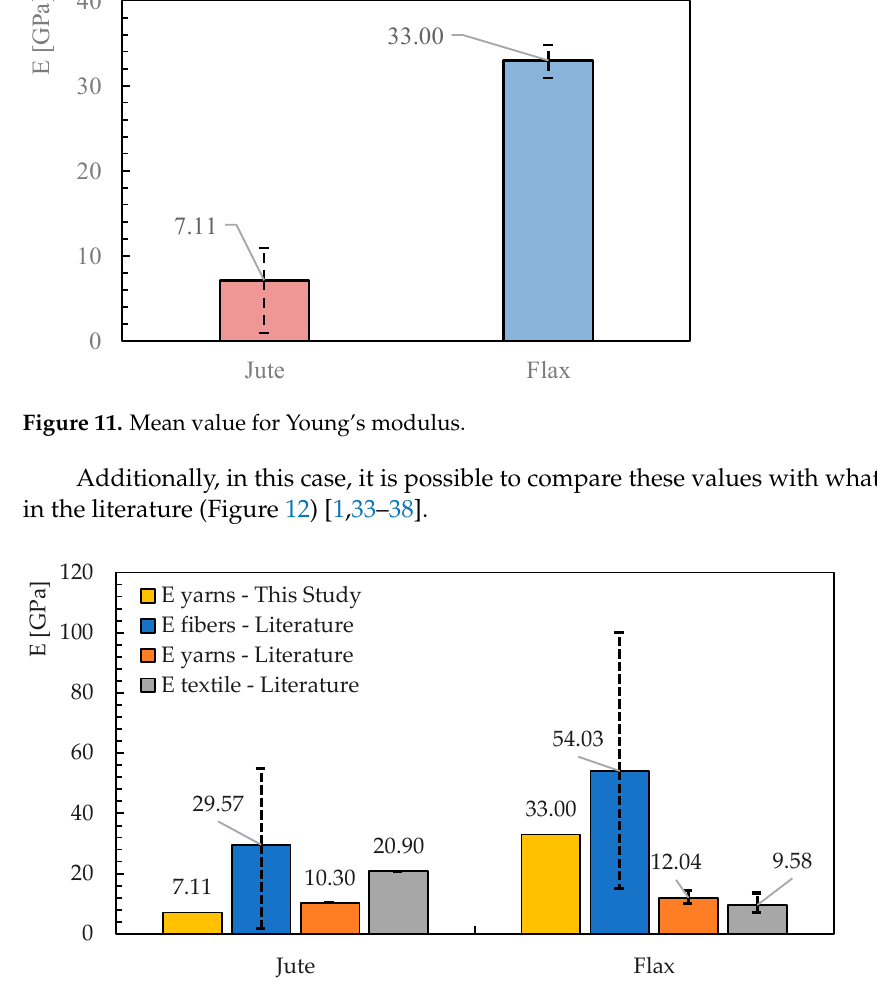
Figure 12. Trendline from which Young’s modulus has been extrapolated for flax fabric.